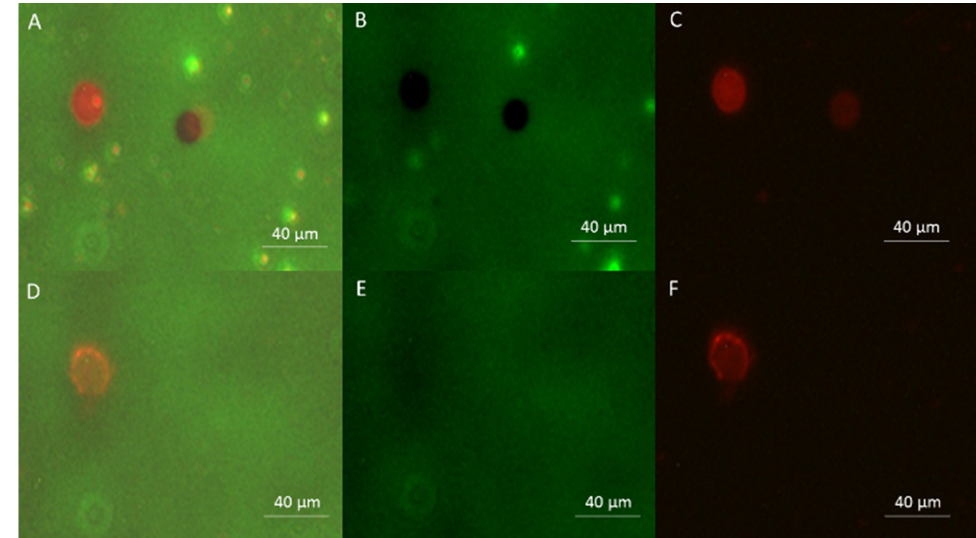
Figure 6. Fluorescence microscopy imaging of GUVs. ( A ) Superposition of LY and Rhodamine imaging before ultrasounds delivery ( B ) Fluorescence imaging of the Lucifer Yellow present on the outside of the GUVs before ultrasounds delivery. ( C ) Fluorescence imaging of the Rhodamine present in the GUV membrane before ultrasounds delivery. ( D ) Superposition of LY and Rhodamine imaging after ultrasounds delivery. ( E ) Fluorescence imaging of the Lucifer Yellow present on the GUVs after ultrasounds delivery. ( F ) Fluorescence imaging of the Rhodamine present in the GUV membrane after ultrasounds delivery. It is important to note that of the two GUVs in panels A, B, and C (before US delivery), only one GUV remains in panels D, E, and F (after US delivery) and was permeabilized, while the second GUV moved away. Also important is the presence of MB observable under Lucifer Yellow fluorescence before the US application (panels A and B). Their absence in panels D and E confirms that US were delivered, and that MB disintegrated after their inertial cavitation at the high MI used in the experiments.